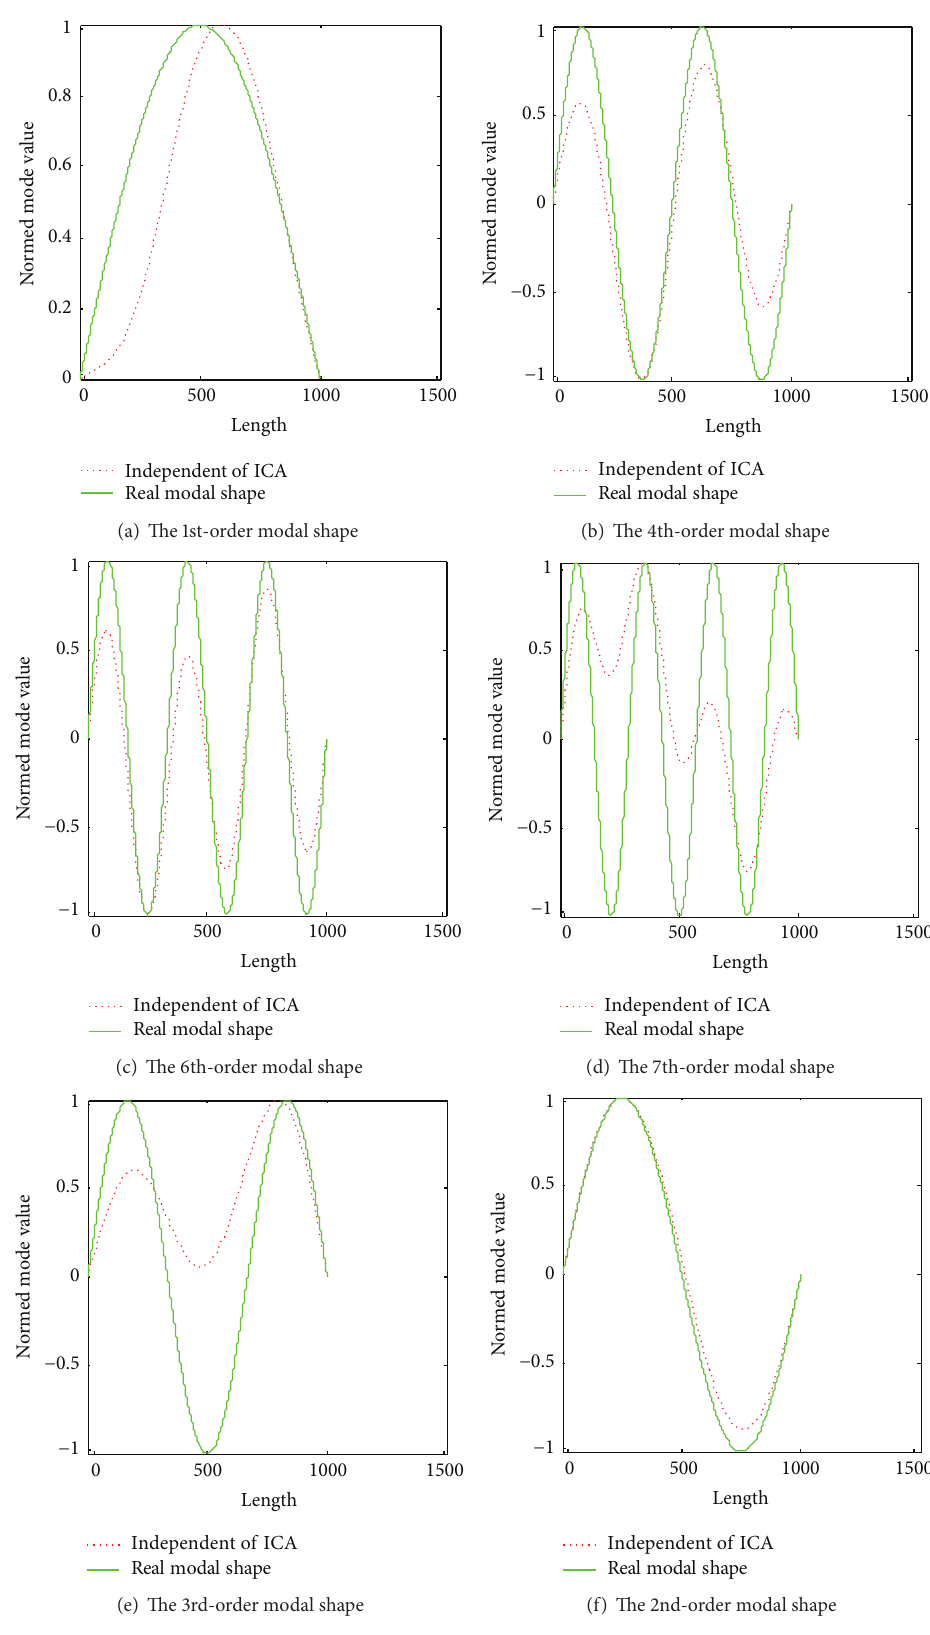
Figure 12: Modal shape comparison between FEA and separating vector by Infomax with gradient descent